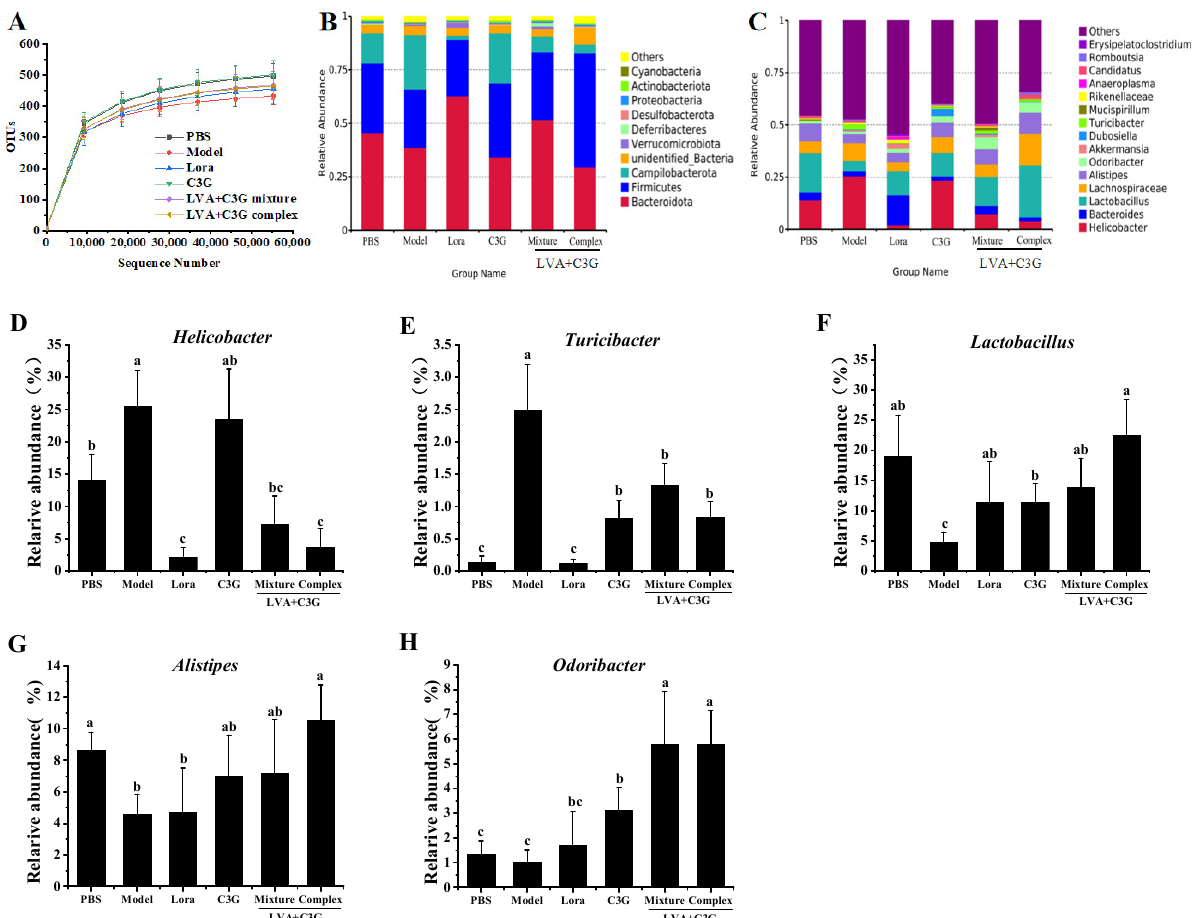
Figure 6. The effect of the C3G-associated samples on microbial composition. ( A ) The rarefaction curves of the OTUs of each group. ( B ) The composition of the flora at the phylum level. ( C ) The composition of the flora at the genus level. ( D – H ) The relative abundance of the selected bacteria at the genus level (( D ) Helicobacter. ( E ) Turicibacter. ( F ) Lactobacillus. ( G ) Alistipes. ( H ) Odoribacter). Significant differences ( p < 0.05) are identified by different letters.